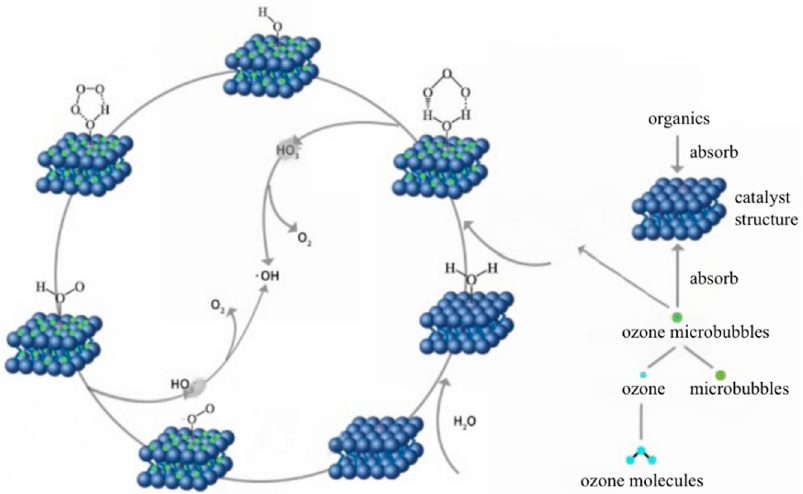
Figure 8. Mechanism of the catalytic process in the MB-catalyst-O 3 system [120]. Reprinted with permission from Ref. [120] .